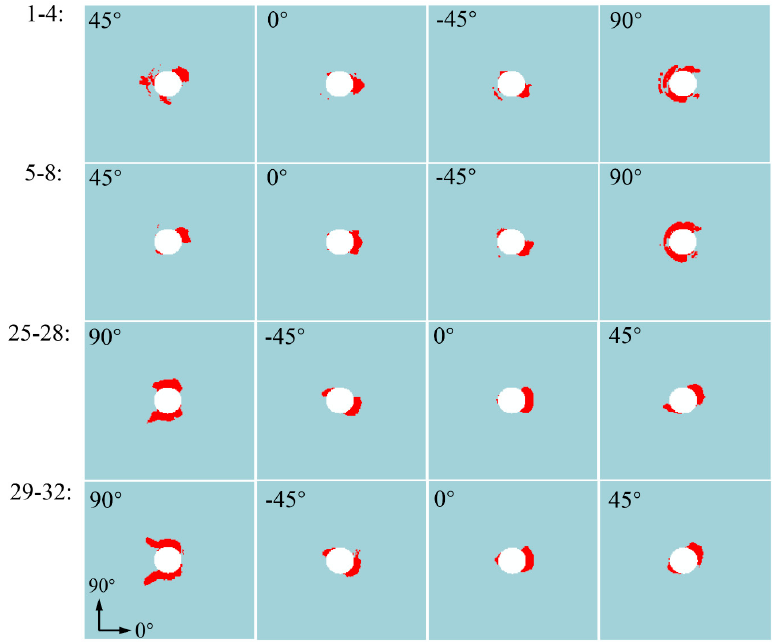
Figure 13. Thin − ply − laminated fiber kinking failure state at point B. Figure 13. Thin-ply-laminated fiber kinking failure state at point B.